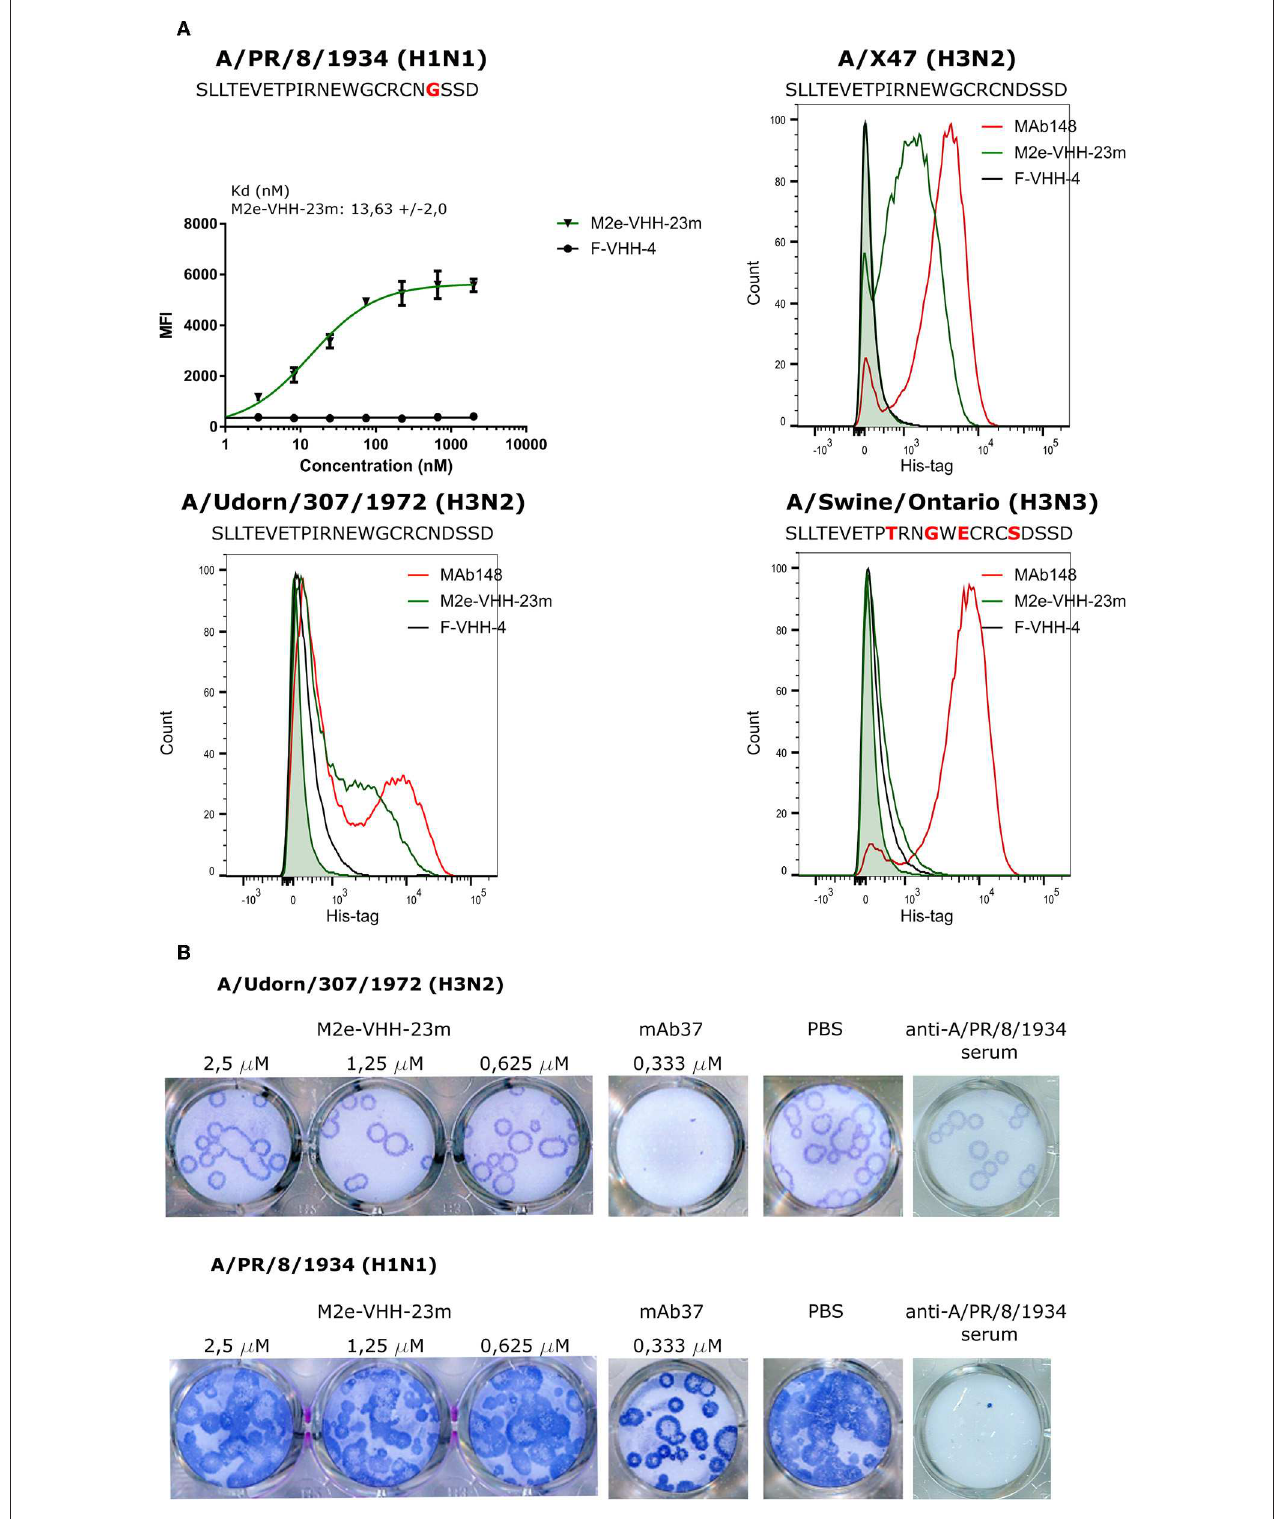
FIGURE 4 | M2e-VHH-23m bind infected cells and lacks in vitro antiviral activity. (A) HEK293T cells were infected with A/Puerto Rico/8/1934 (H1N1), A/X47 (H3N2), A/Udorn/307/1972 (H3N2) or A/Swine/Ontario (H3N3) virus. The M2e sequences of the different viruses are shown above each graph, residues that differ from